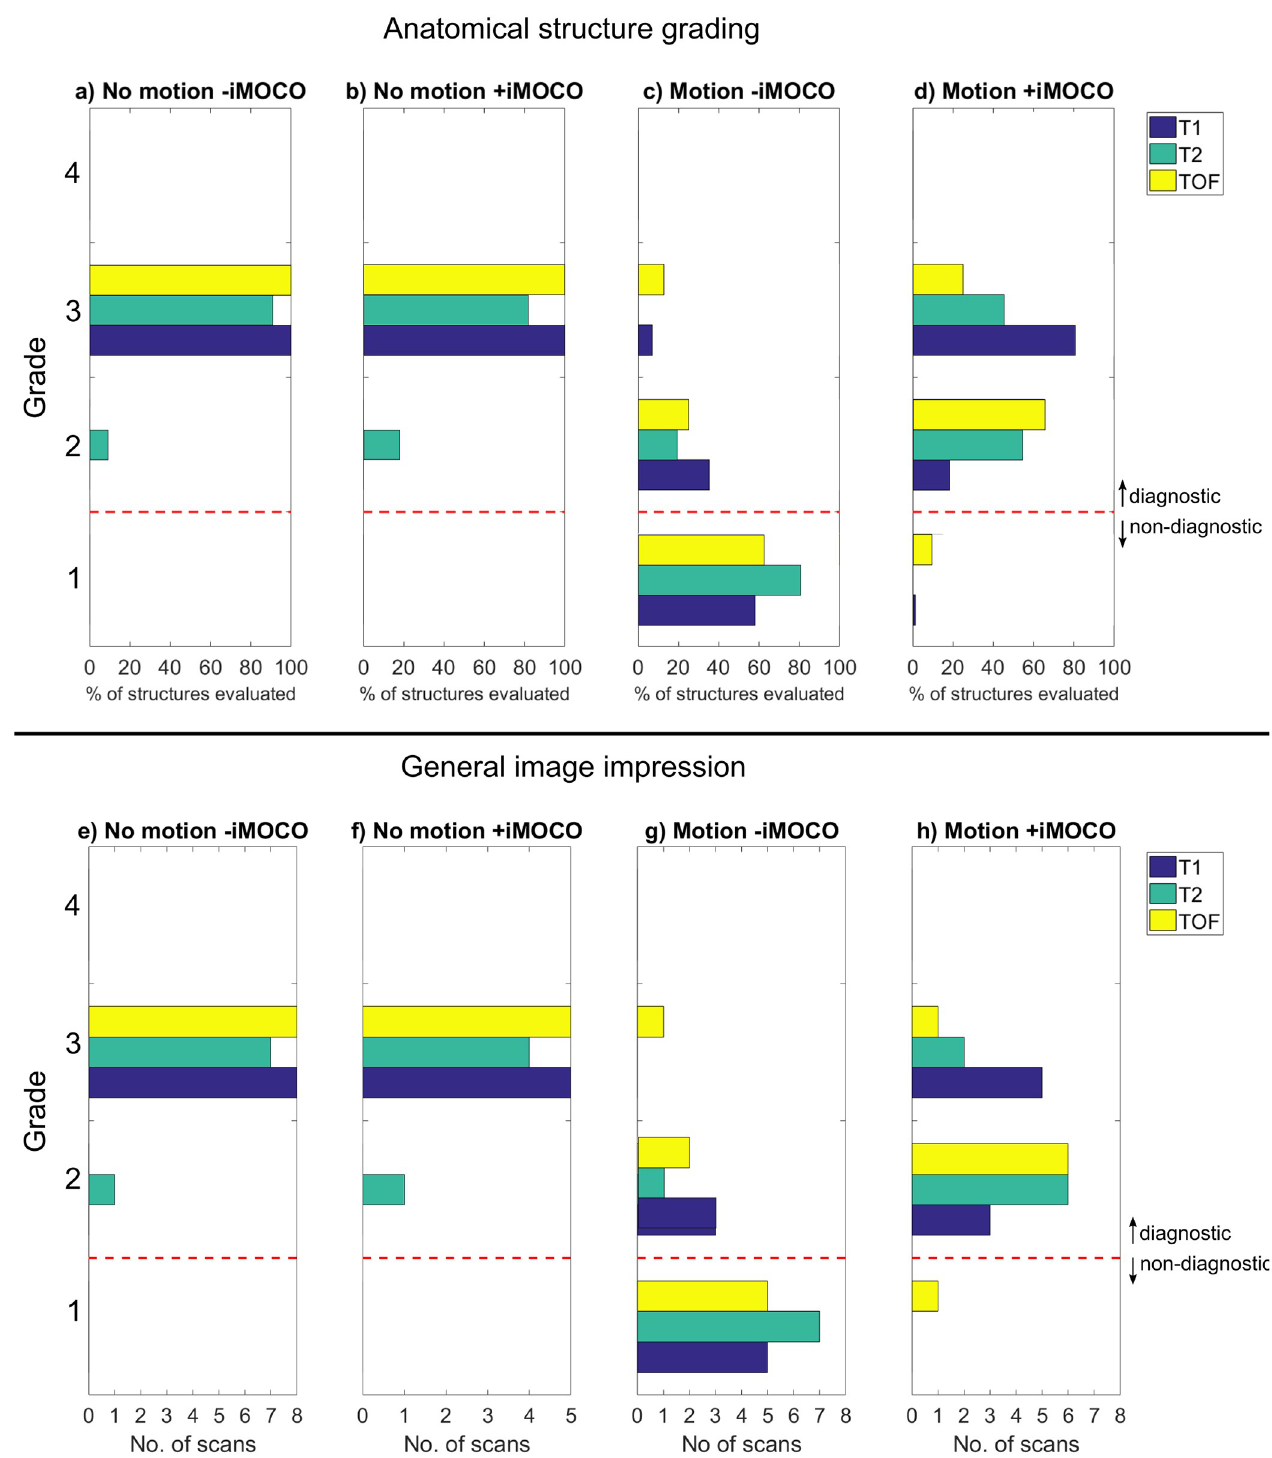
Fig 5. Summary of the grading of image quality. Panels a – d show the pooled grades of all anatomical structures, given for the three types of sequence (T1, T2, and TOF), while panels e – h show the general image impression (GII) grades for the three sequences.